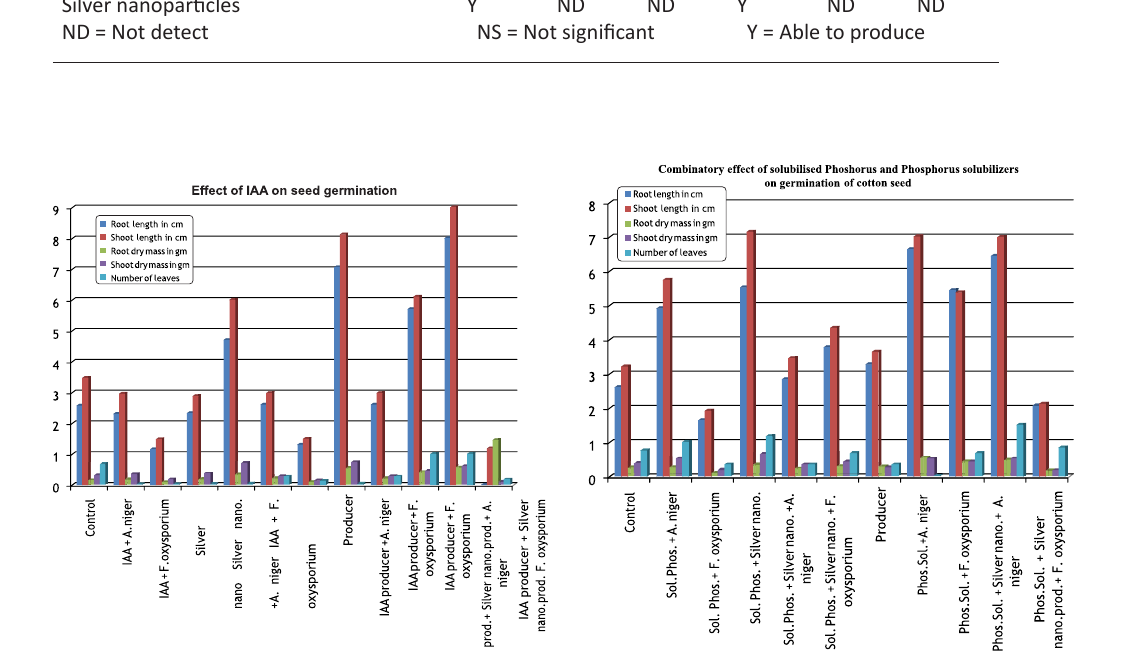
Fig. 3. Effect of Indole Acetic Acid on seed germination